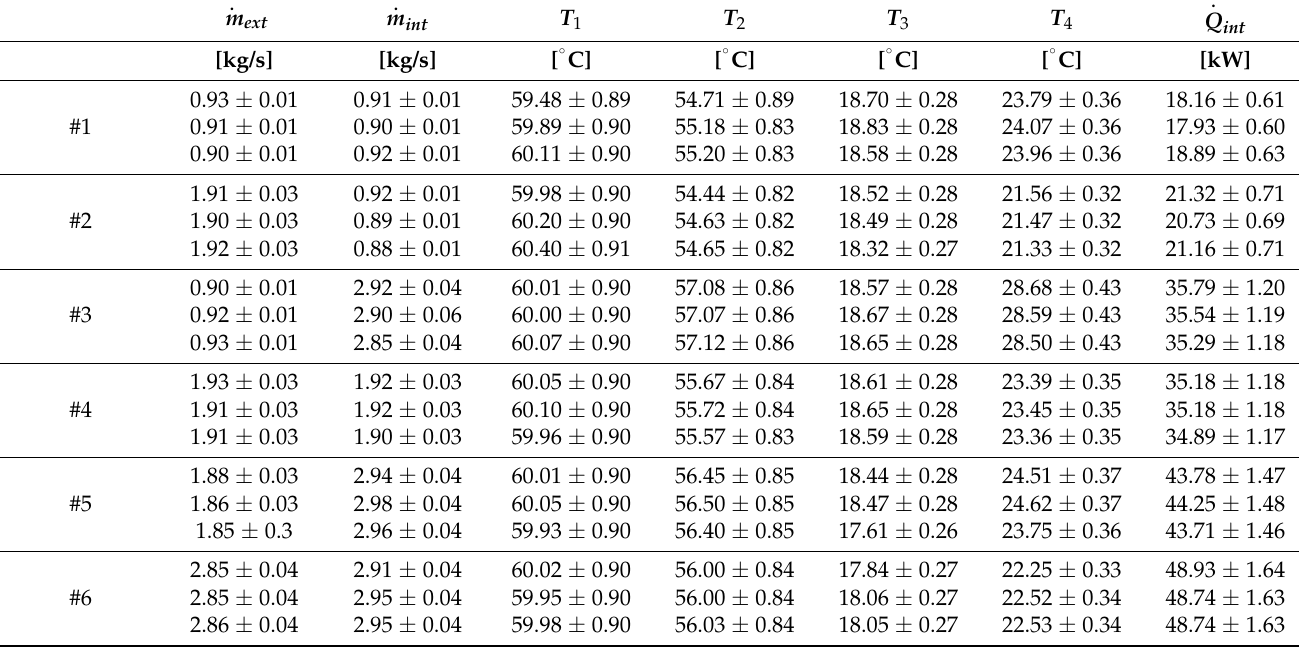
Table 2. Experimental measurement data of tube-filled foam heat